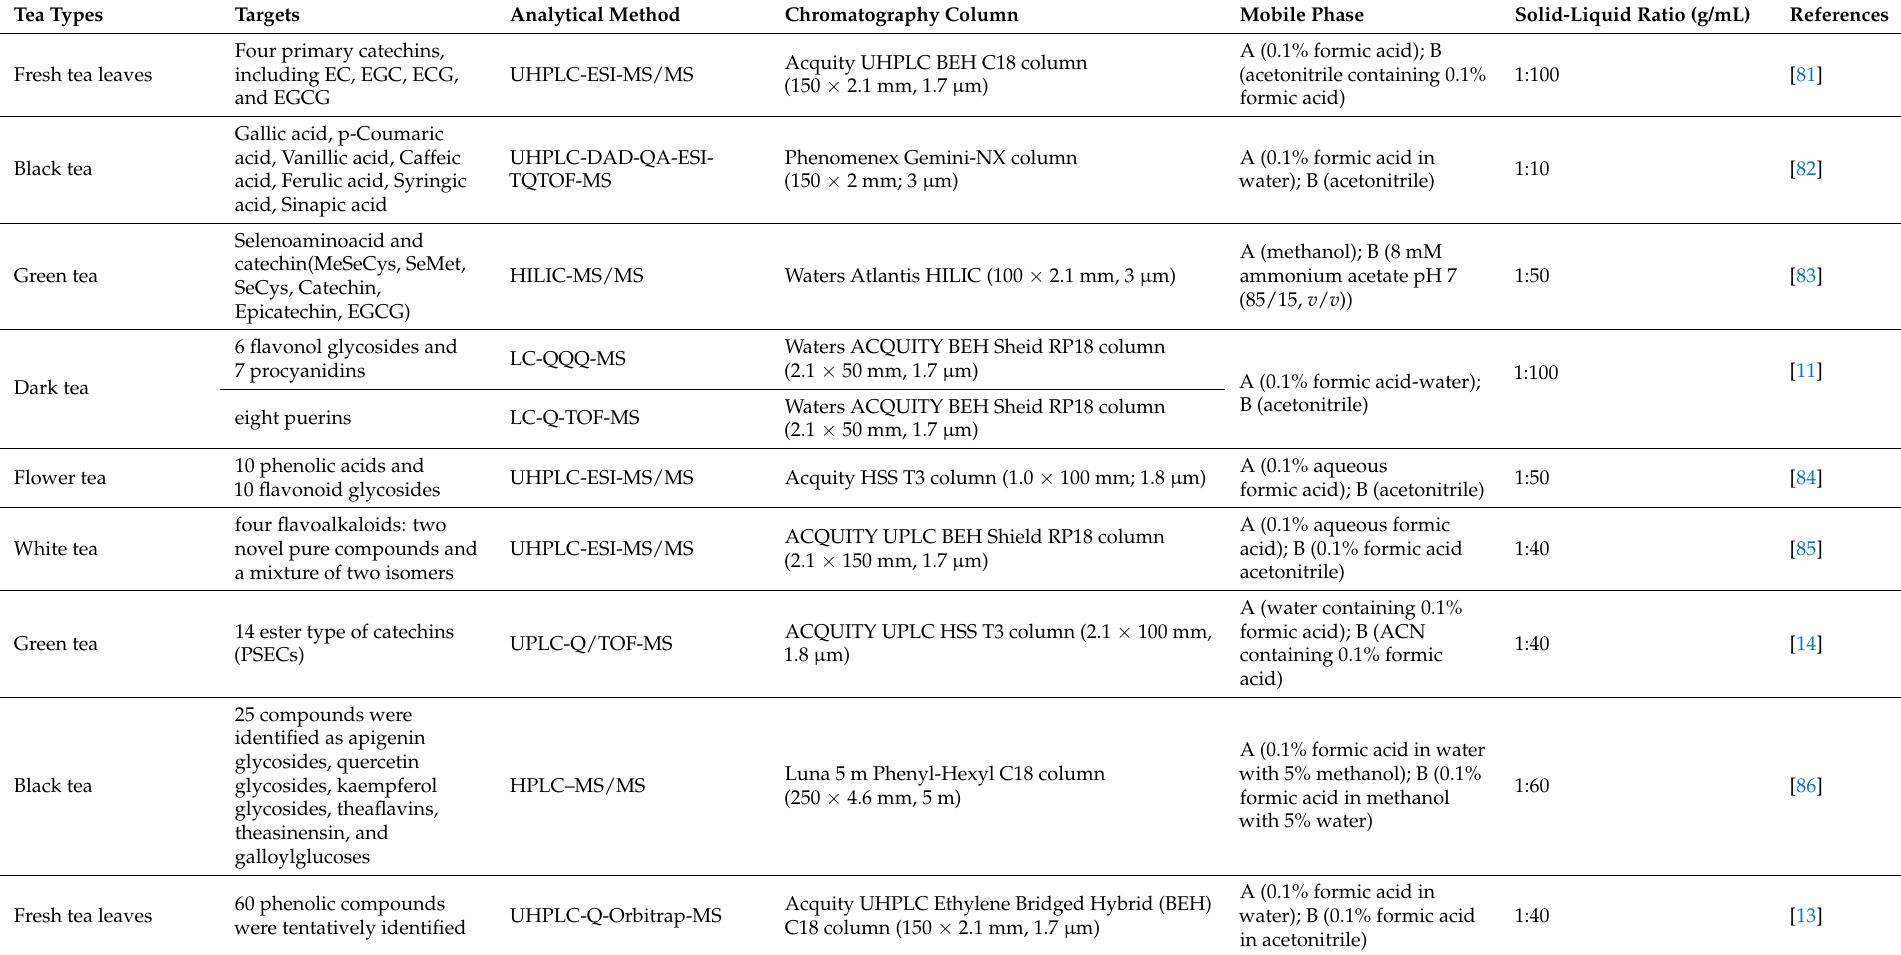
Table 3. Recent applications of LC–MS analysis of individual polyphenols in